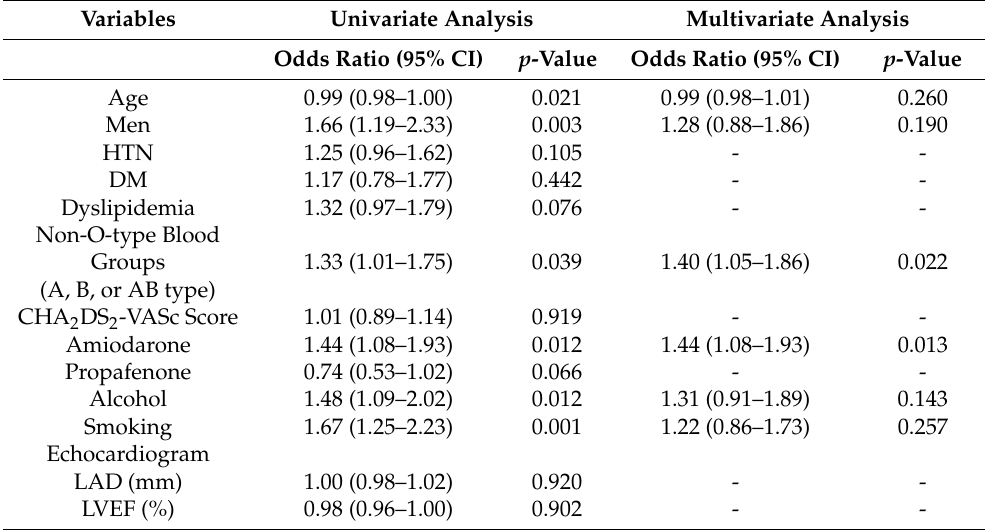
Table 3. Univariate and multivariate analysis of very late recurrence in patients with the